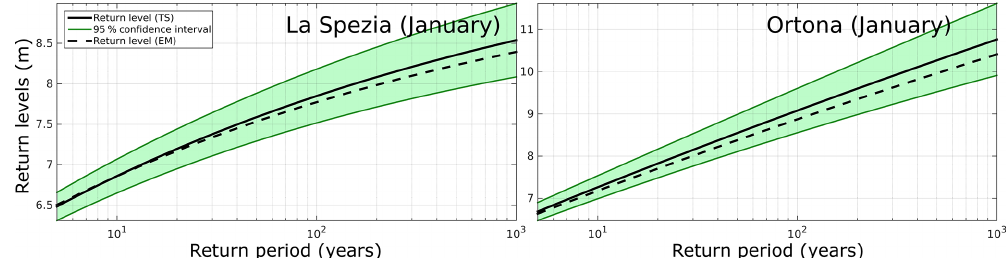
Figure 11. Return levels for La Spezia and Ortona for the month of January, estimated by the TS methodology (black continuous line) and by the EM (black dashed line). The green area represents the 95% confidence interval estimated by the TS